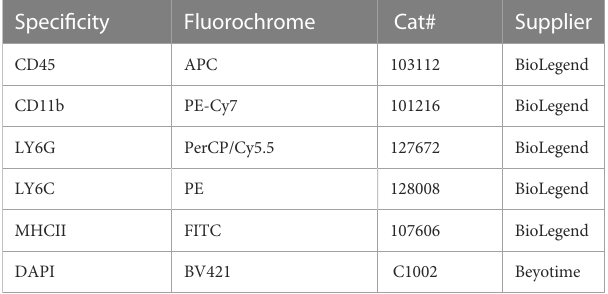
TABLE 2 Sources of commercial antibodies used in fl ow-cytometry